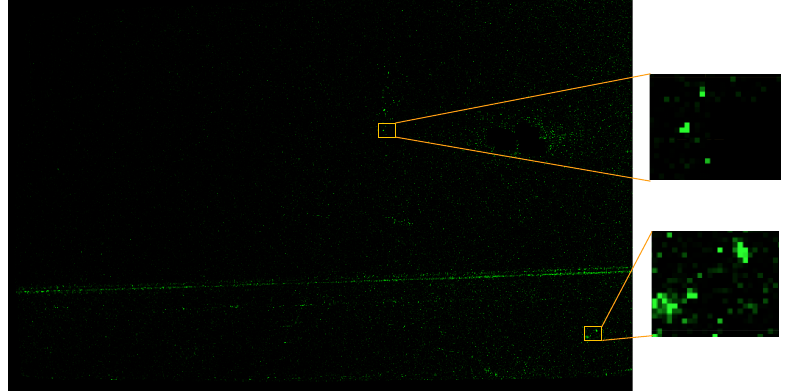
Figure 5. Resulting texture image T with zoomed texture